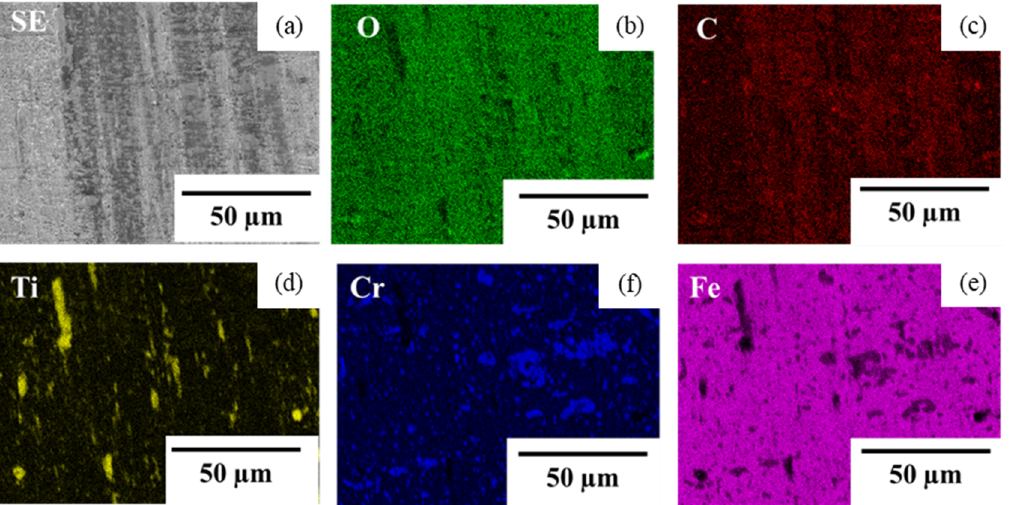
Figure 14. SEM image and element mapping at the center of the contact interface between the pure titanium and the Cs-SKD11 punch, after continuously forging 20 times with r = 50%. ( a ) SE image, ( b ) Oxide (O), ( c ) Nitride (N), ( d ) Titanium (Ti), ( e ) Chromium (Cr), ( f ) Iron (Fe).